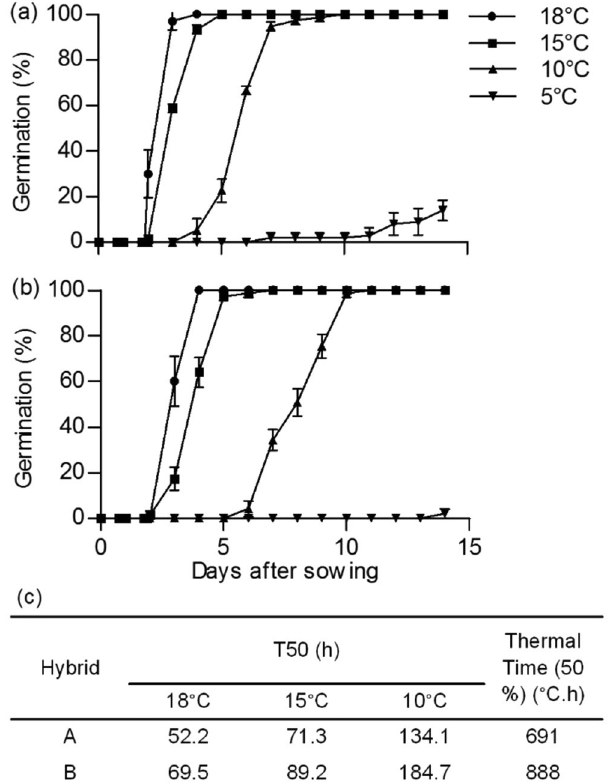
Figure 1. Effect of temperature on seed germination. Germination of hybrids A ( a ) and B ( a ) at 4 different temperatures and cardinal temperatures for germination ( c ). Each point is the mean of 3 replicates of 25 seeds each ± SD.